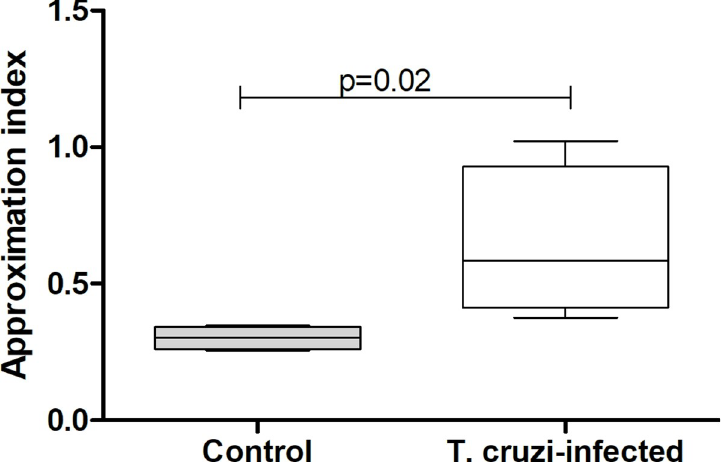
Fig 3. Nymph approximation index comparing the spatial relation between Rhodnius prolixus nymphs and hosts, as a function of infection status. Data depicted represent the median (horizontal line) of the cumulative number of nymphs found closer than 1.5 cm from the host in the last five minutes of each recorded hour normalized by the total number of nymphs present in each of four independent assays (25% - 75%,